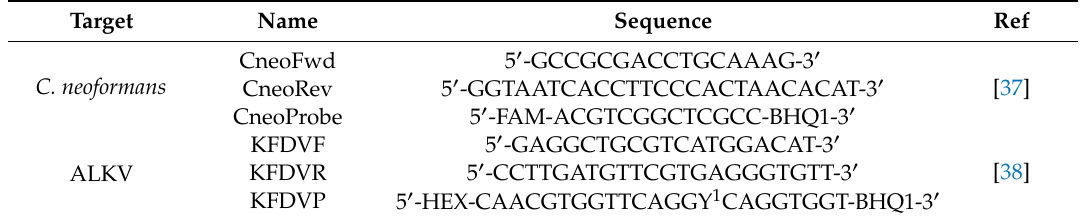
Table A1. Primers and probes used in this study to detect C. neoformans and